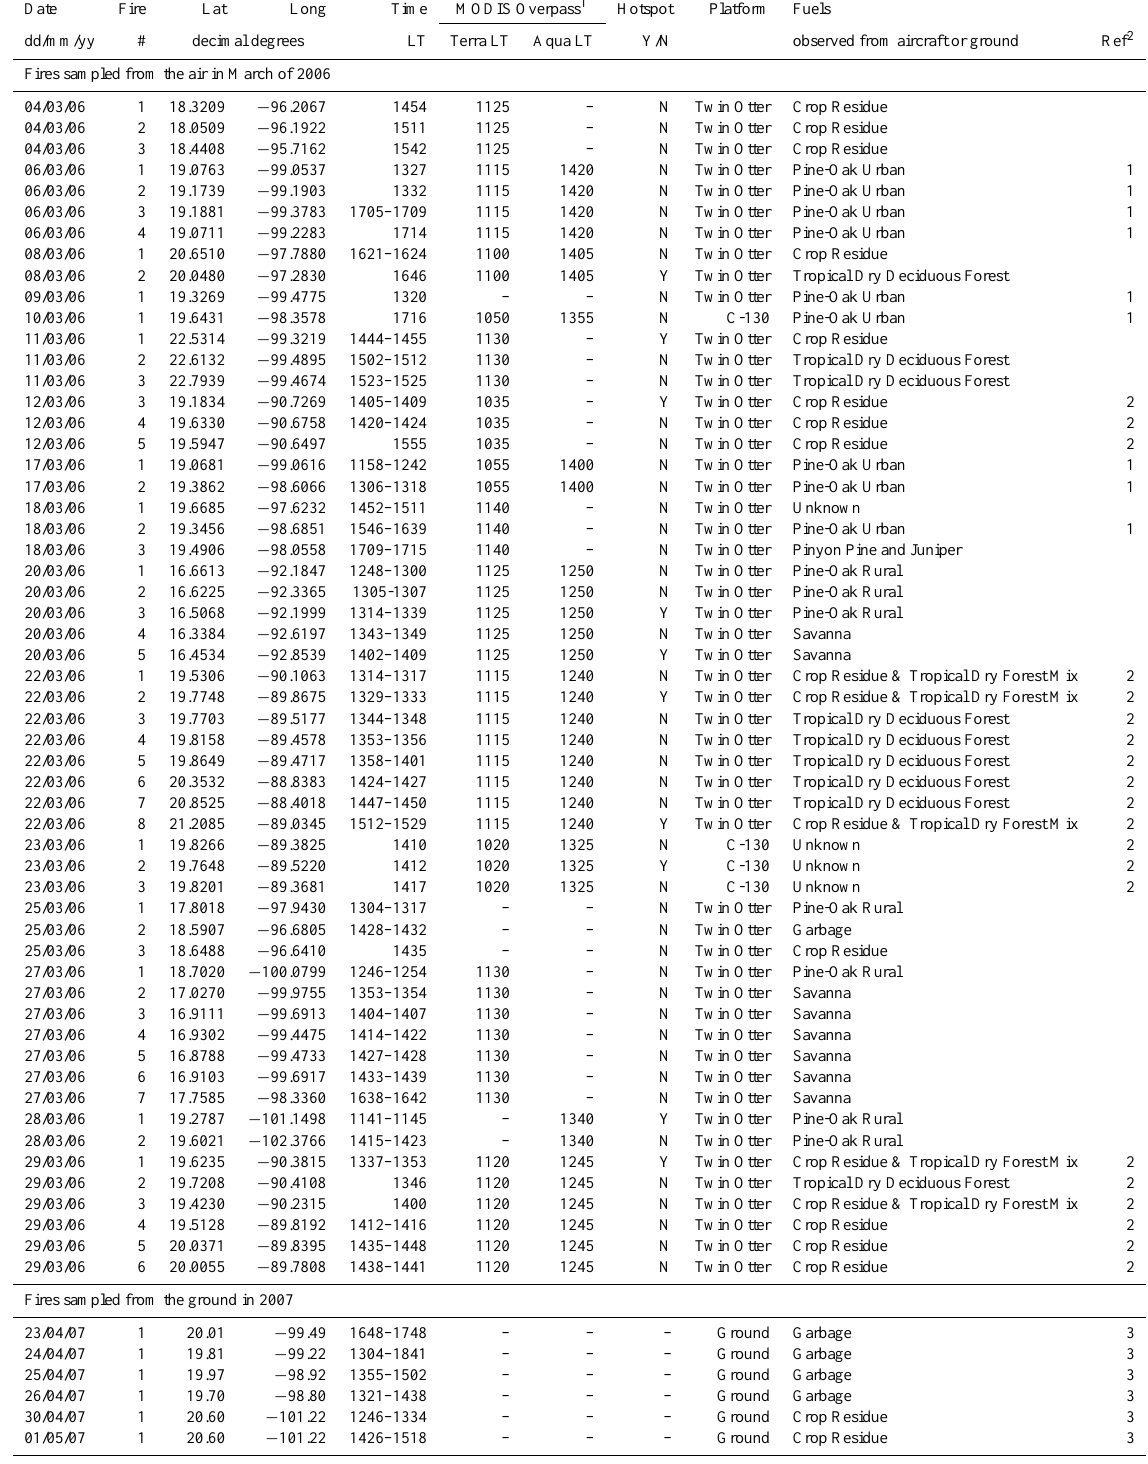
Table 1. Details of the open fires (not including biofuels) sampled in Mexico during MILAGRO. Date Fire Lat Long Time MODIS Overpass 1 Hotspot Platform Fuels dd/mm/yy decimal degrees LT Terra LT Aqua LT Y/N observed from aircraft or ground Ref 2 Fires sampled from the air in March of